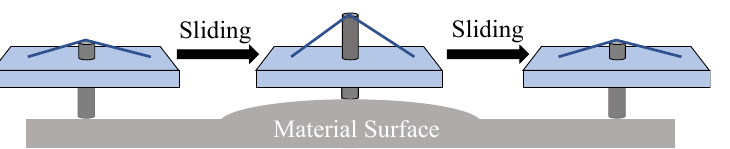
Figure 4. SMA sensor for sensing micro-force.